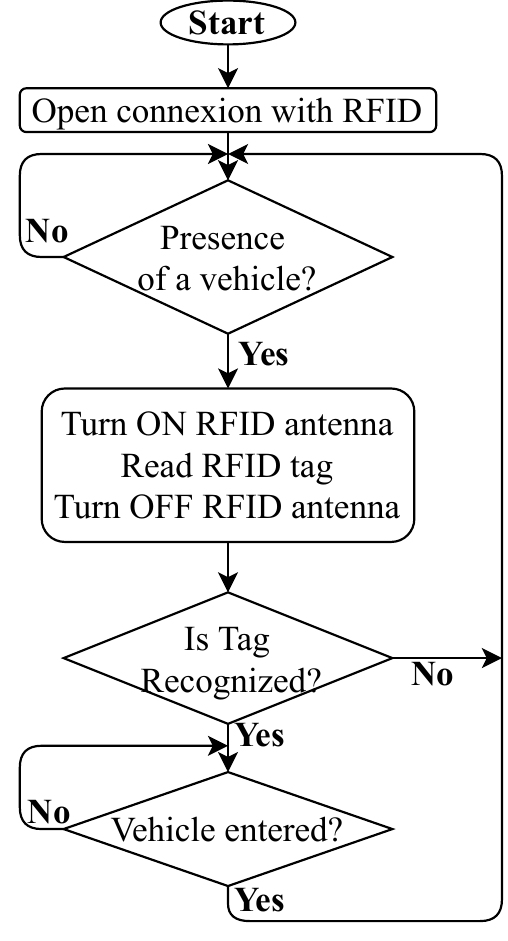
Figure 8. Flowchart of the parking entrance